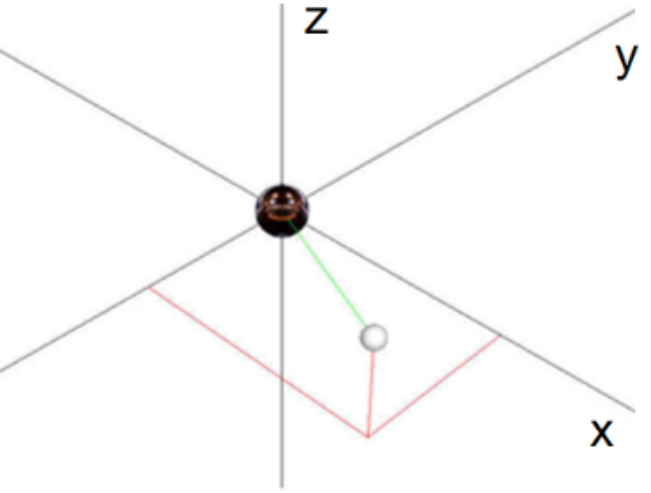
Figure 7. Interface elements of the “point charge” visuo-haptic environment developed with Chai